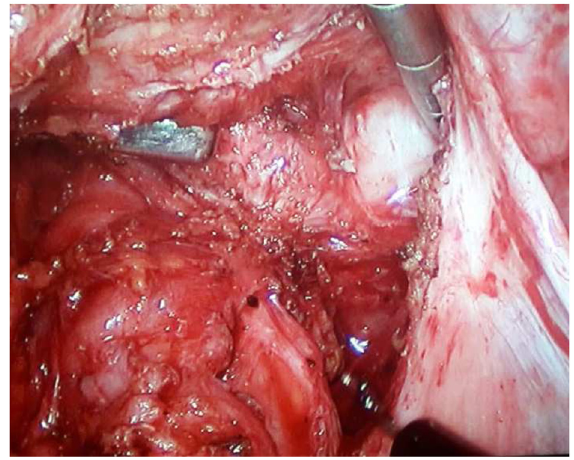
Figure 9. Colorectal image of deep infiltrating endometriosis after shaving of a nodule. Rectal shaving of endometriotic nodules has proven to be a safe and fast surgical procedure that alleviates pain and gastrointestinal symptoms even in low locations of the disease. Image is from surgery performed by the